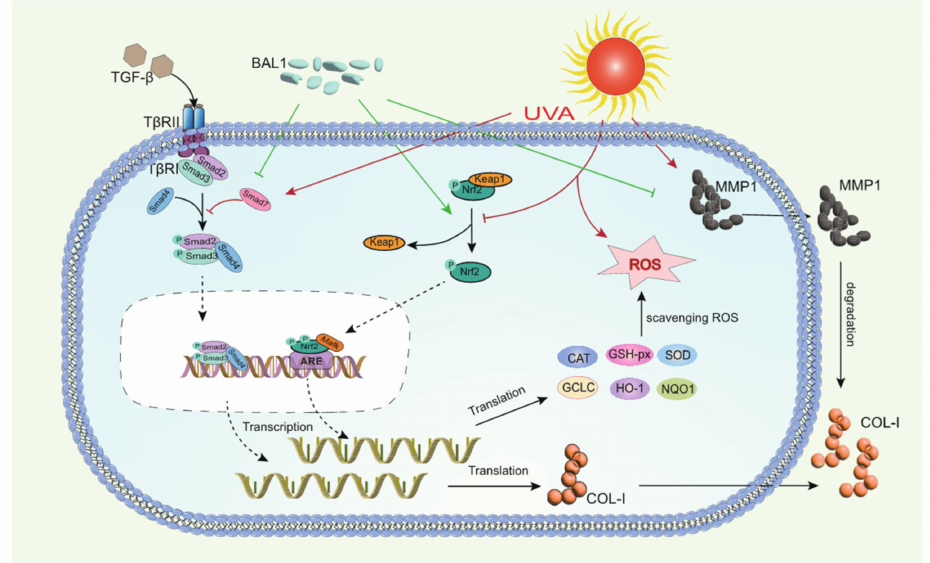
Figure 7. Mechanistic diagram of the regulation of NRF2/Keap1 and TGF- β /Smad by BAL1 in human skin